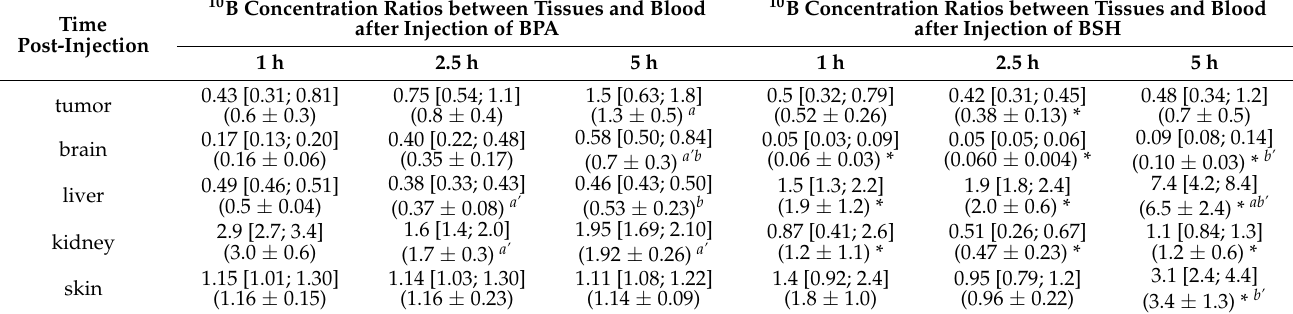
Table 2. 10 B concentration ratios between tissues and blood after injection of BSH or BPA. Data are presented as median and the 25th and 75th percentiles and mean ( ± SD). Significance of differences was defined by Mann–Whitney pairwise comparison followed by a Bonferroni post-test. a Statistical difference according to 1-h group with the same compound ( p < 0.05). a’ Statistical difference according to 1-h group with the same compound ( p < 0.001). b Statistical difference according to 2.5-h group with the same compound ( p < 0.05). b’ Statistical difference according to 2.5-h group with the same compound ( p < 0.001). * Statistical difference according to BPA group at the same time points ( p < 0.05).